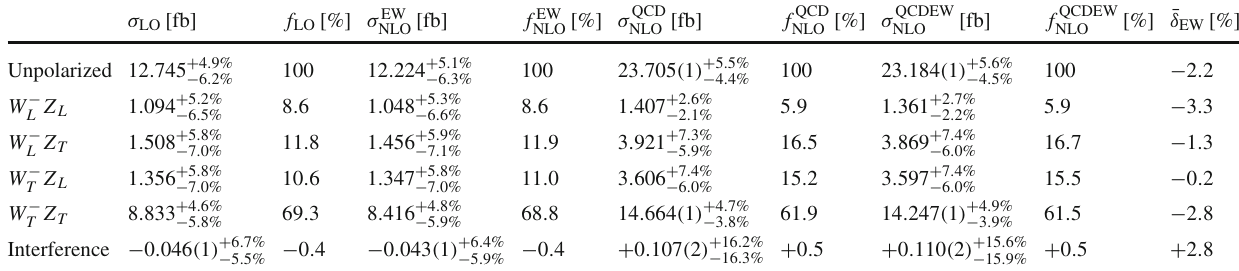
Table 1 Unpolarized anddoubly polarizedcross sections infb together ties (in parenthesis) are given on the last digits of the central prediction with polarization fractions calculated at LO, NLO EW, NLO QCD, and when significant. Seven-point scale uncertainty is also provided for the NLO QCD+EW, all in the DPA, in the W Z center-of-mass system for cross sections as sub- and superscripts in percent. In the last column the the process pp → W − Z → e − ν e μ + μ − + X . The statistical uncertain- EW correction relative to the NLO QCD prediction is provided σ σ EW [fb] f EW [%] σ QCD [fb] f QCD [%] σ QCDEW [fb] f QCDEW LO [fb] f LO [%] NLO NLO NLO NLO NLO NLO Unpolarized 12 . 745 + 4 . 9% − 6 .